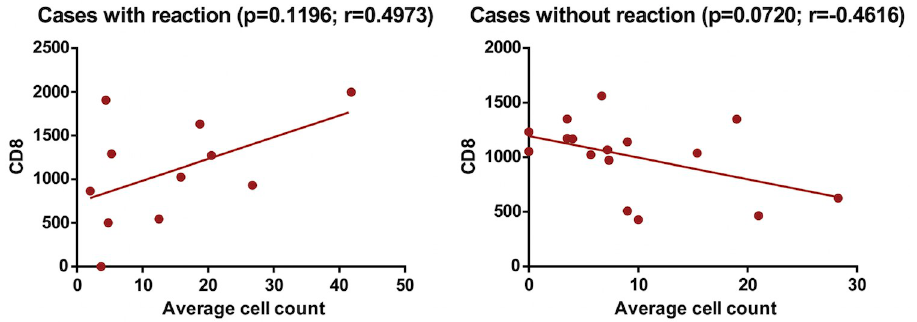
Fig 4. Correlation of cells marked with FOXP3 and CD8 T cells among patients with HIV and with leprosy coinfection, according to the presence of reverse reaction.